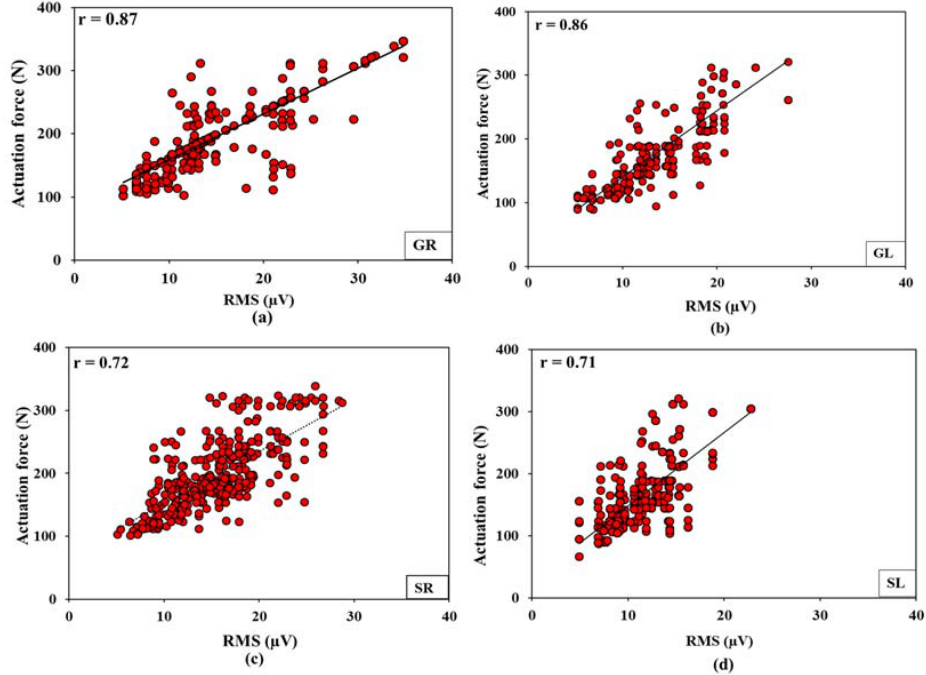
Figure 10. Correlations between actuation forces and electromyography feature (RMS) ( a ) gastrocnemius right, ( b ) gastrocnemius left, ( c ) soleus right, and ( d ) soleus left muscles. Right muscles: brake operation, left muscles: clutch operation.